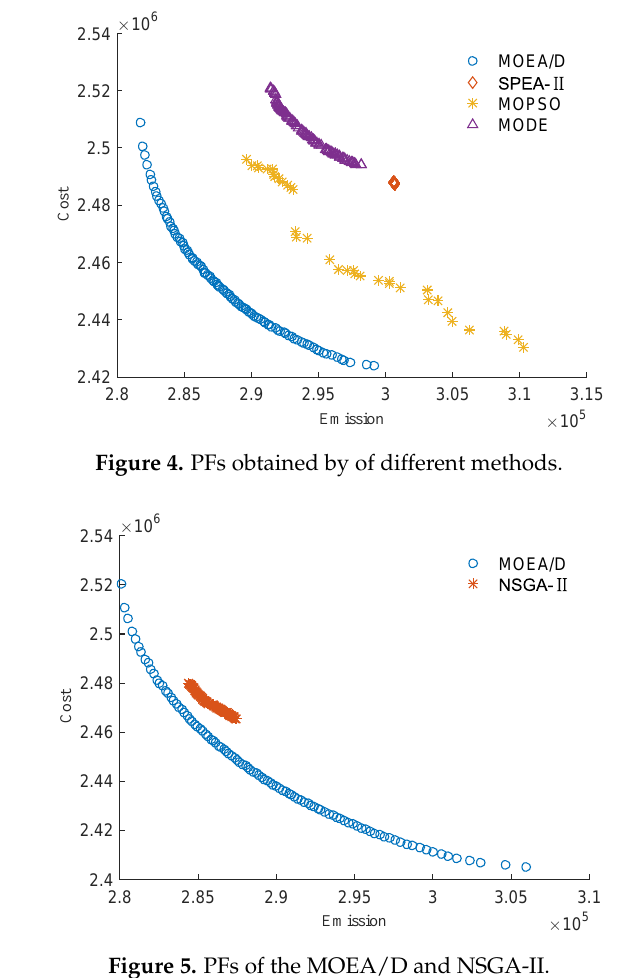
Figure 5. PFs of the MOEA/D and NSGA-II. Table 4. The solutions and average computation time (seconds) of MOEA/D and NSGA-II (Iterations = 10 5 ).